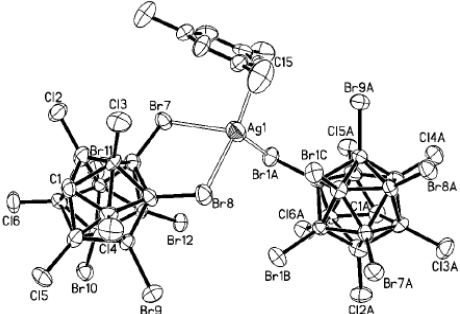
Figure 74. Fragment of X-ray structure of ({( η 1 -mesitylene)Ag[1-HCB 11 -2,3,4,5,6-Cl 5 -7,8,9,10,11,12-Br 6 ]}·mesitylene) n . Reprinted with permission from reference [99]. Copyright © (2000) American Chemical Society.